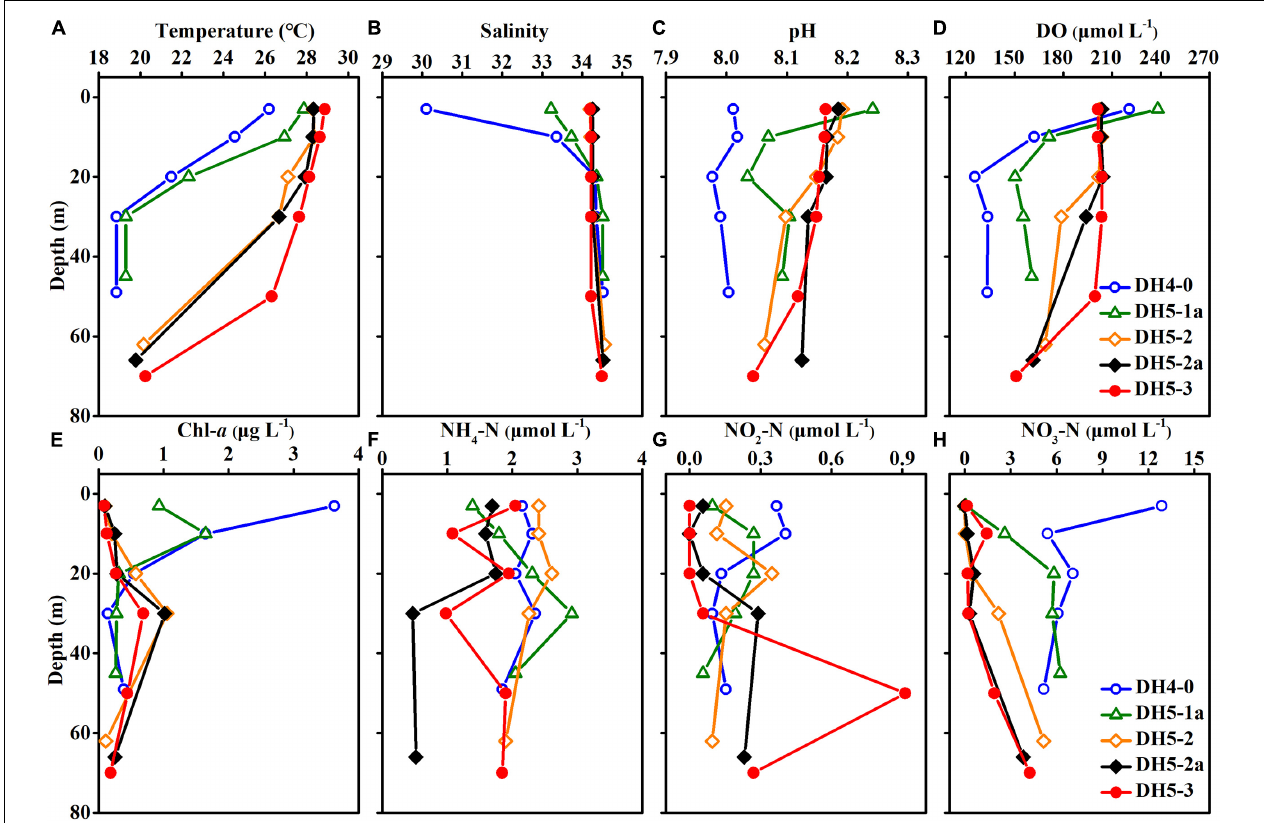
FIGURE 3 | Depth profiles of (A) temperature, (B) salinity, (C) pH, (D) dissolved oxygen (DO) concentrations, (E) chlorophyll- a (Chl-a) concentrations, (F) ammonium (NH 4 –N) concentrations, (G) nitrite (NO 2 –N) concentrations and (H) nitrate (NO 3 –N)